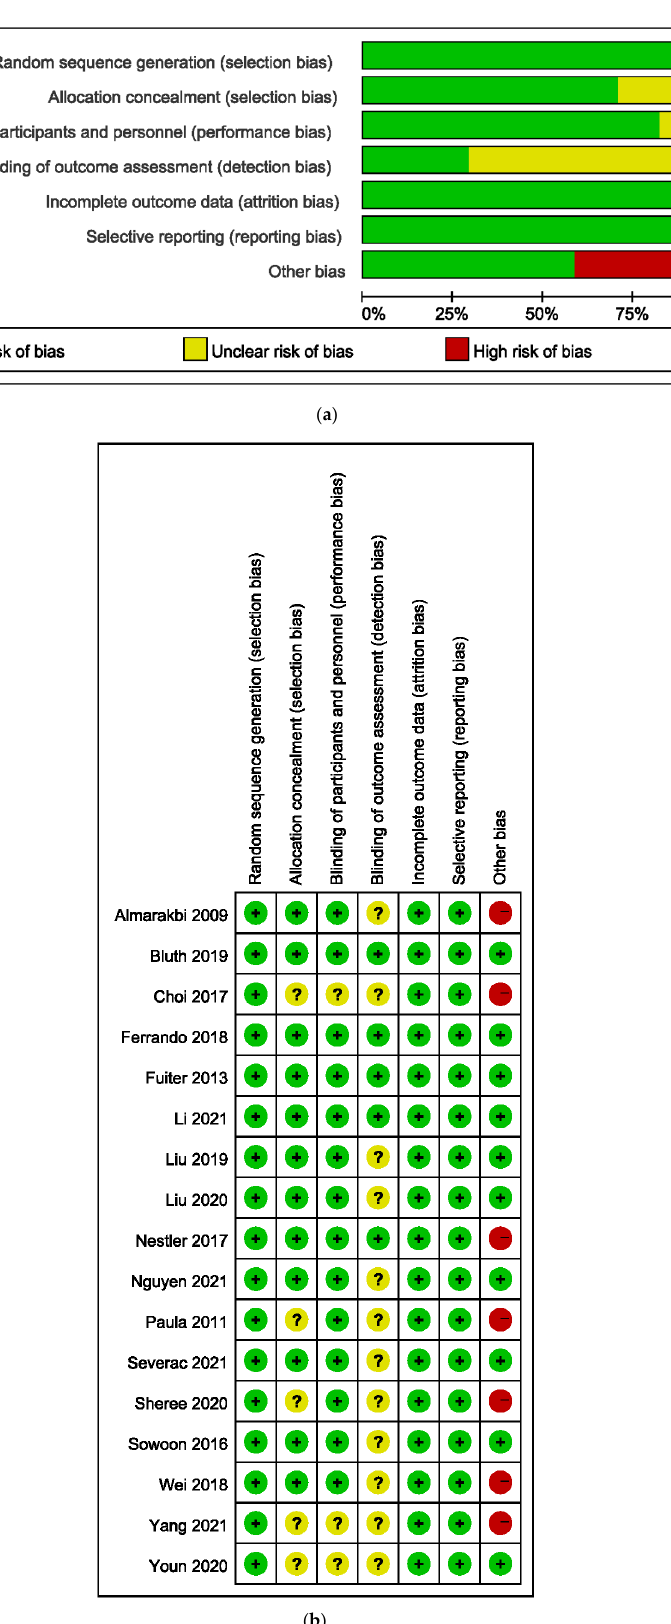
Figure 2. Evaluation of risk bias for included RCTs: ( a ) percentage plot of seven types of bias for the included studies; ( b ) summary of bias for each study [16 – 32].